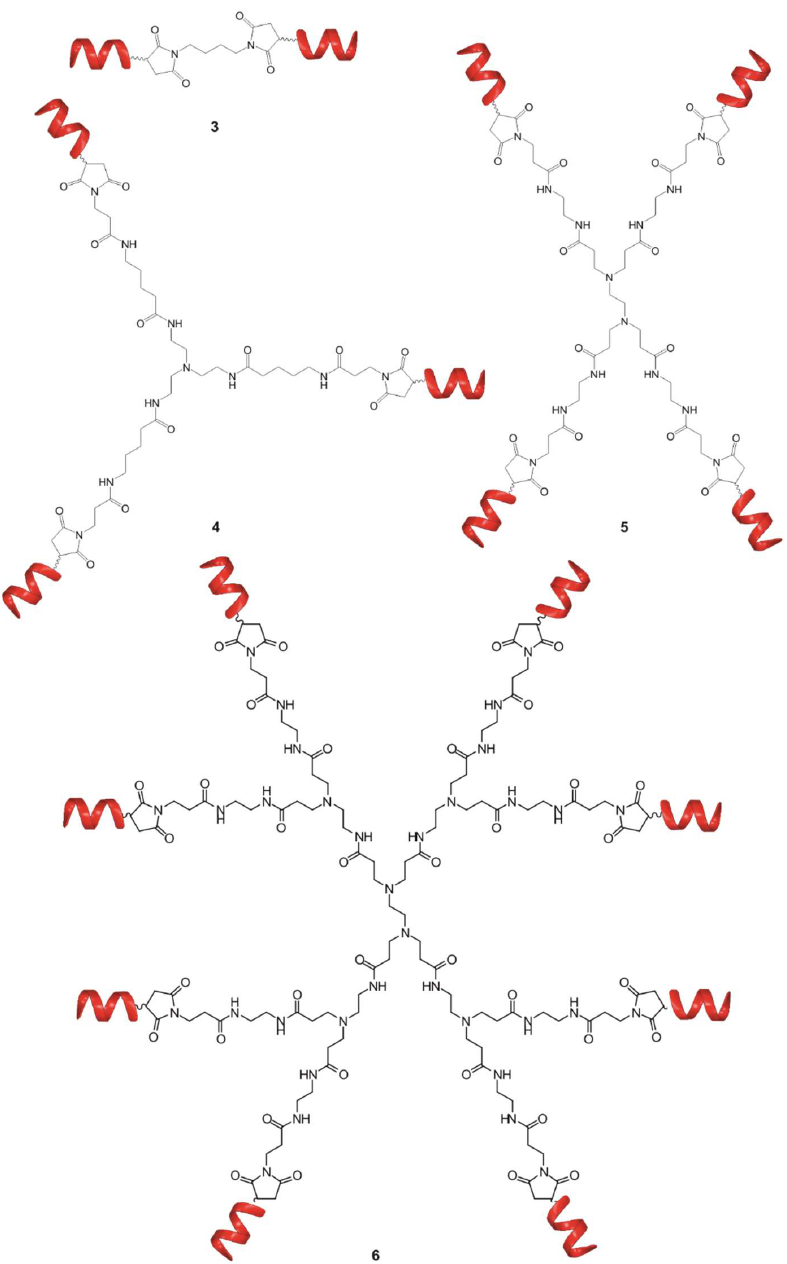
Figure 3. Schematic representation of bivalent ( 3 ), trivalent ( 4 ), tetravalent ( 5 ) and octavalent ( 6 ) foldameric conjugates.